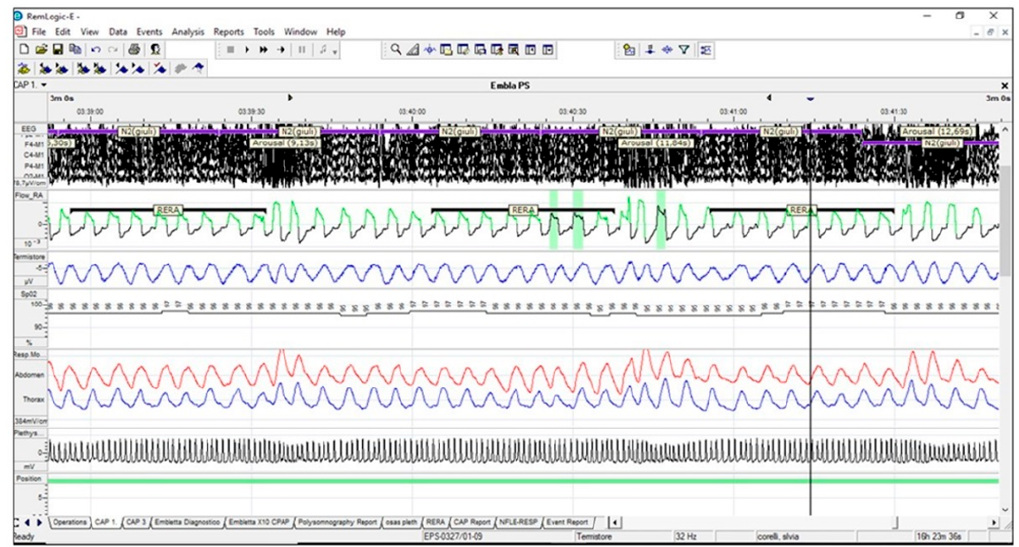
Figure4. UARSischaracterizedbylowUAcollapsibility. Airflowisslightlylimitedwithever-increasing Figure 4. UARS is characterized by low UA collapsibility. Airflow is slightly limited with respiratory e ff ort, until arousal from sleep occurs. No arterial desaturations are observed with RERAs, ever-increasing respiratory effort, until arousal from sleep occurs. No arterial desaturations are but these respiratory events lead to sleep fragmentation. Legend: UARS: upper airways resistance observed with RERAs, but these respiratory events lead to sleep fragmentation. Legend: UARS: syndrome; UA: upper airways; RERA: respiratory-e ff ort-related upper airways resistance syndrome; UA: upper airways; RERA: respiratory-effort-related arousals.